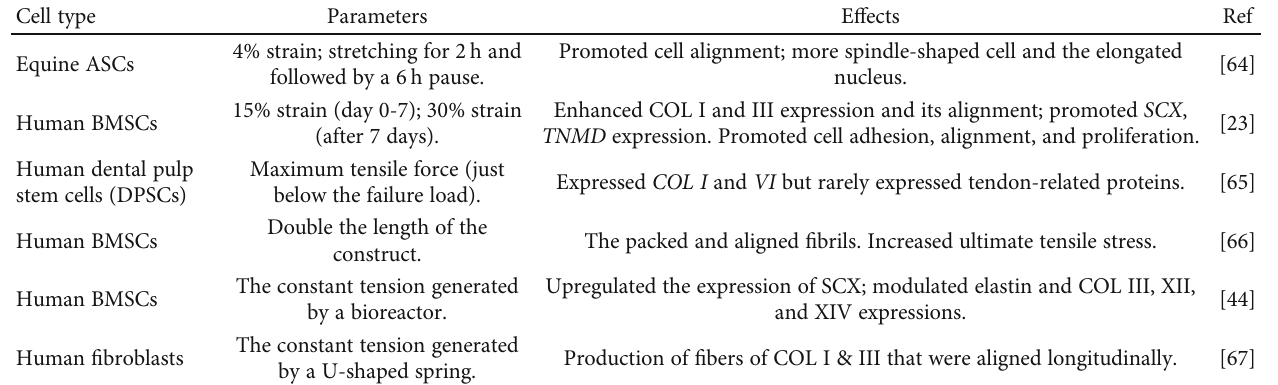
Figure 2: A custom-made bioreactor. Engineered tendon (cell-seeded sca ff olds) is placed within each chamber (blue arrow), with two ends anchored. Amplitude and frequency of the bioreactor could be set. Table 2: Static uniaxial stretching used in tendon tissue